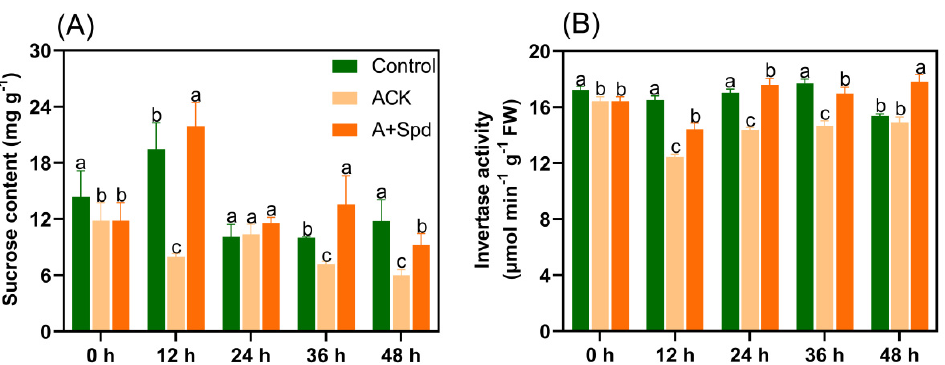
Figure 3. Effects of exogenous Spd on amylase activity in aged seeds. ( A ) the iodine-stained image of starch transformation at 36 h after germination. The size of the white area reflects the transformation ability of seed starch. The larger the white area, the stronger the ability of starch to transform into soluble sugar. ( B ) A quantitative analysis of amylase activity. Control − healthy seeds; ACK − artificially aged seeds; A+Spd − aged seeds with Spd treatment. Different lowercase letters above the bars indicate significantly different levels among the treatments ( p < 0.05, Lsd). A 0.05 µ M concentration of exogenous Spd was used.